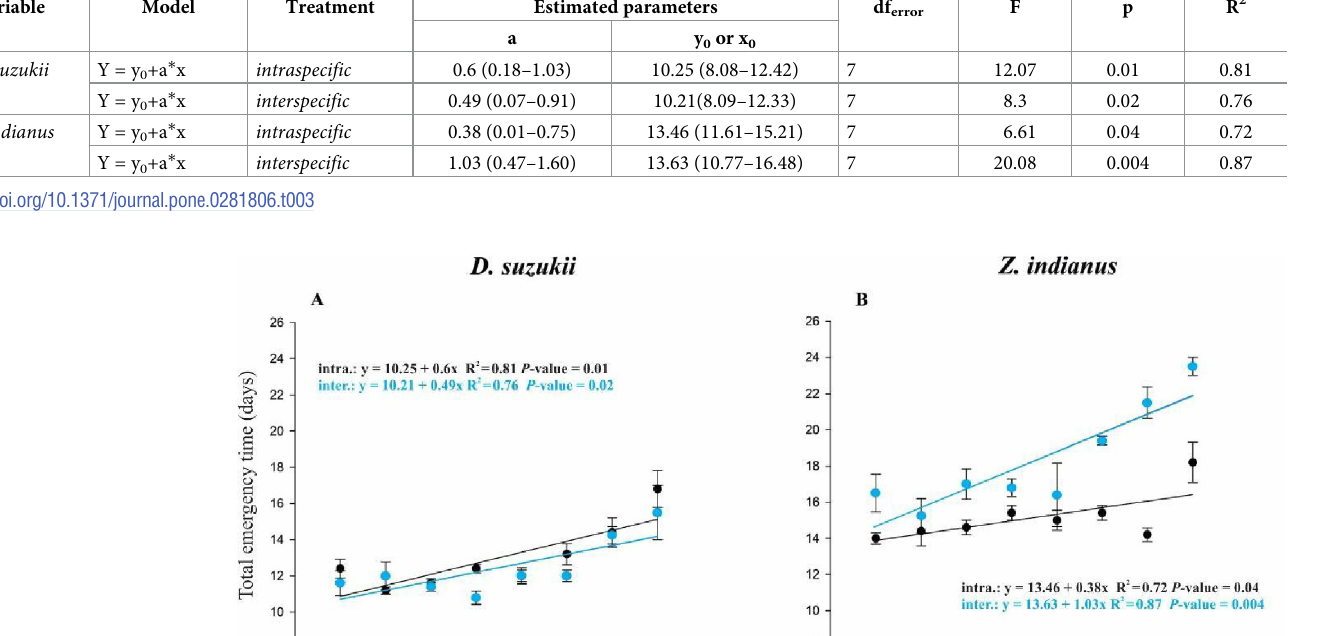
Table 3. Summary of regression analyses for mean emergence times of Drosophila suzukii and Zaprionus indianus (shown in Fig 4). Variable